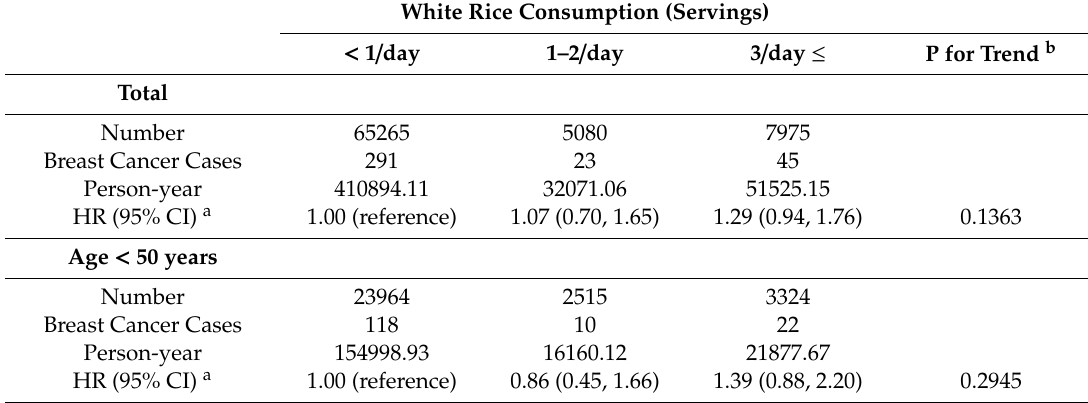
Table 5. Hazard Ratios (HR) and 95% Confidence intervals (CI) of Breast Cancer according to White Rice